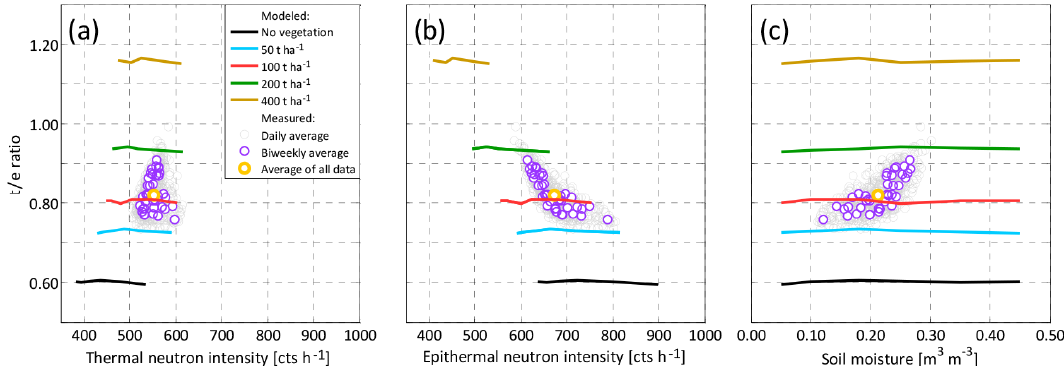
Figure 8. Neutron intensities measured at Gludsted plantation in the time period 2013–2015 and modeled using the model tree trunk, fo- liage, air. Ground-level thermal-to-epithermal neutron intensity ratio plotted against measured and modeled (a) ground-level thermal neutron intensity, (b) ground-level epithermal neutron intensity and (c) volumetric soil